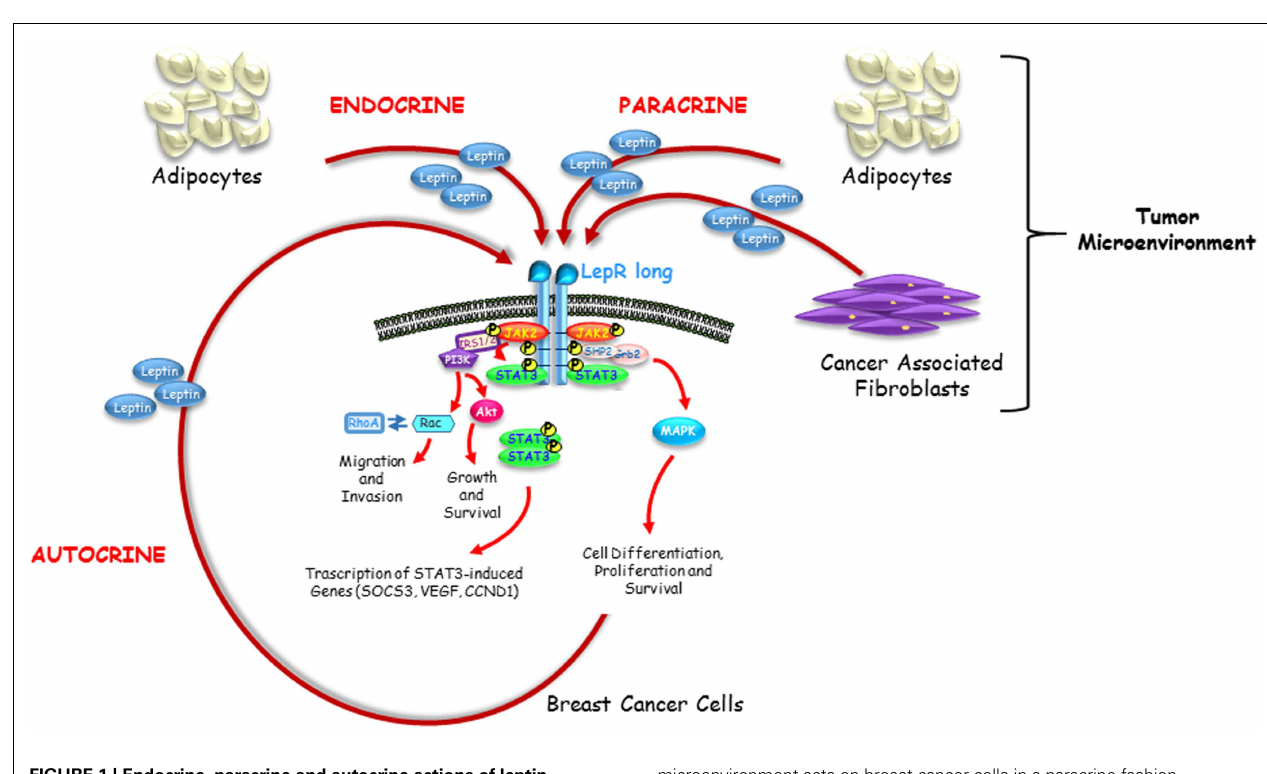
FIGURE 1 | Endocrine, paracrine and autocrine actions of leptin . Leptin circulating at high levels in obesity impacts breast cancer initiation and progression in an endocrine manner. Leptin secreted by adipocytes and fibroblasts resident in breast tumor